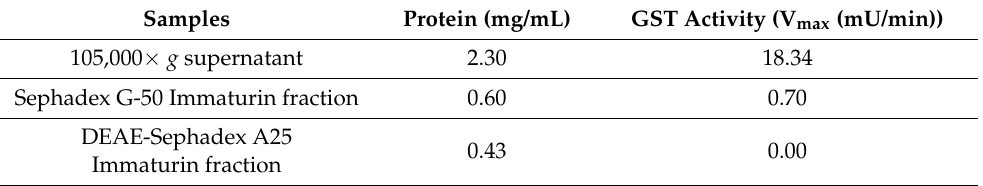
Table 1. Glutathione-S-transferase enzyme assay of immaturin. Samples Protein (mg/mL) 105,000 × g supernatant